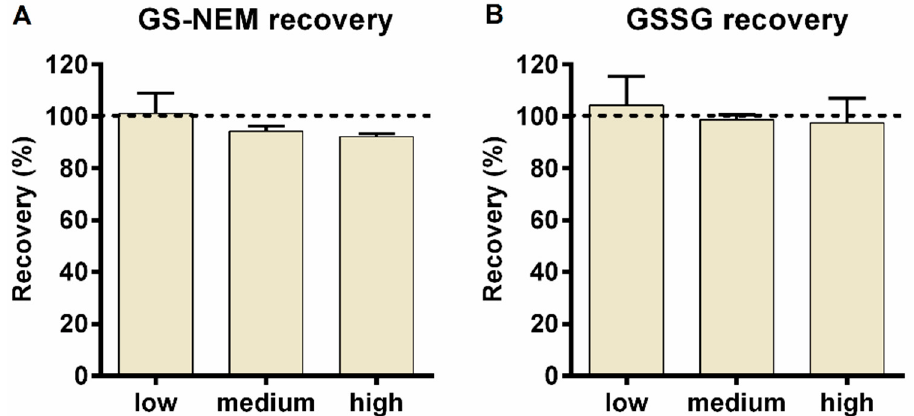
Figure 5. ( A ) GS-NEM and ( B ) GSSG spike-in experiments. Recovery was determined by adding defined amounts of GS-NEM or GSSG at low (10 nmol of GS-NEM, 0.02 nmol of GSSG), medium (20 nmol of GS-NEM, 0.06 nmol of GSSG), and high (40 nmol of GS-NEM, 0.2 nmol of GSSG) concentration into LS174T wild type cell cultures before 80% methanol cell extraction. GS-NEM and GSSG recovery experiments were performed separately ( n = 3 for